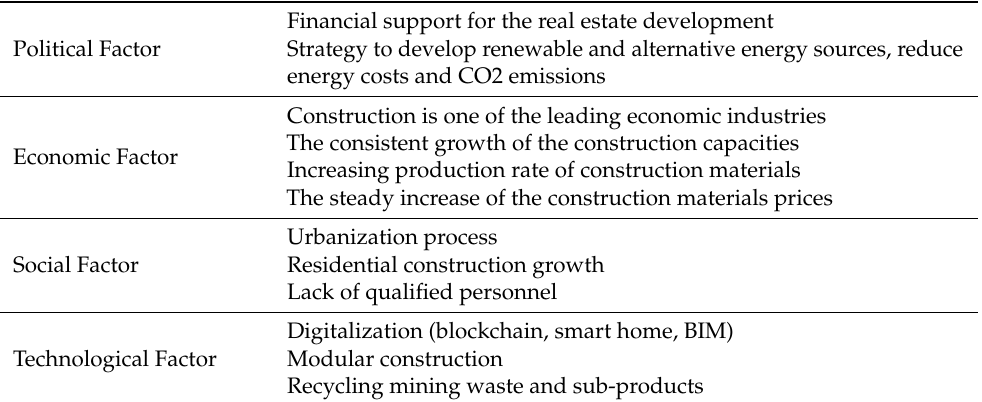
Table 4. PEST analysis of construction trends in